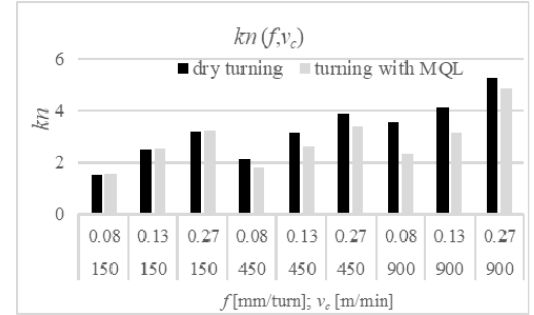
Figure 11. Constancy factor of cutting force Fc in aluminium composite turning with uncoated carbide tool